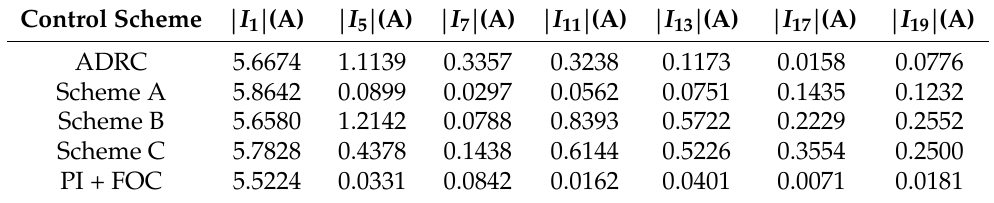
Figure 10. The actual speed of the system based on: ( a ) ADRC; ( b ) scheme A; ( c ) scheme B; ( d ) scheme C; ( e ) PI + FOC. Table 5. Harmonic components of the motor phase current under different control schemes.